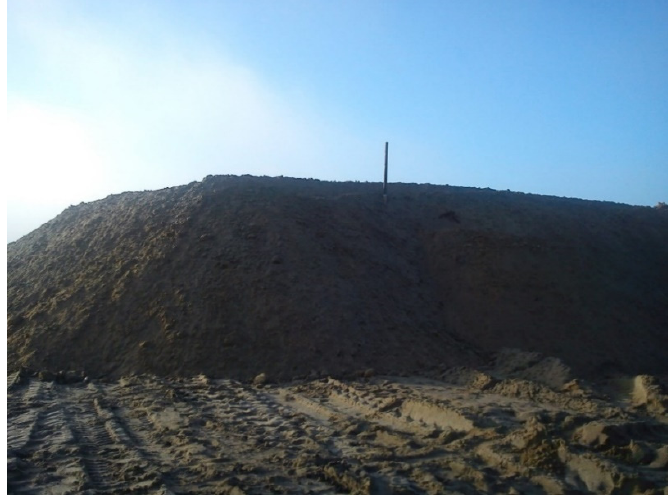
Figure 14. The preloading embankment at Ostrów Brdowski in Szczecin with a disc benchmark visible (photo M. Olszewska).